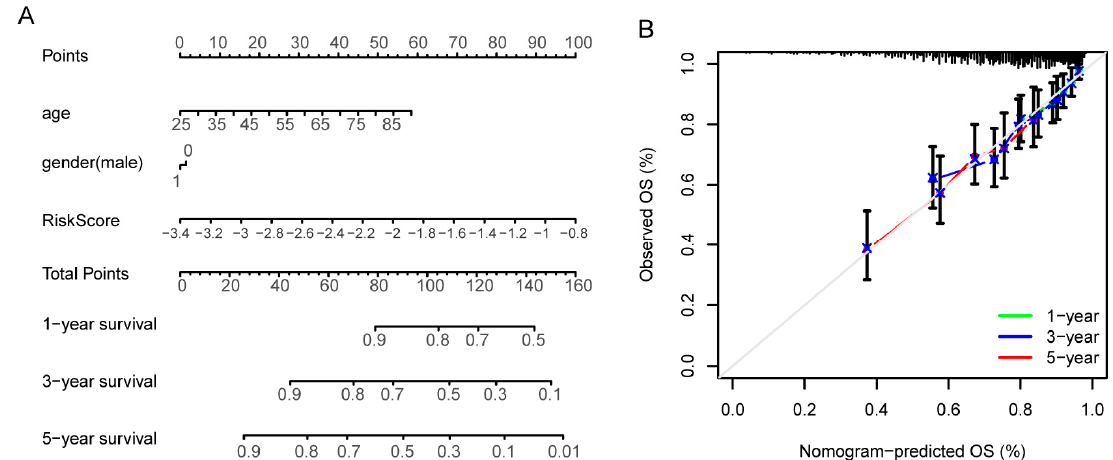
Figure 7. E ff ects of 740Y-P stimulation on autophagy-related genes in 786-O cells. *** p value < 0.001 vs. Ov-NC; ### p value < 0.001 vs. Ov-SPAG9. Ov-NC: cells transfected with control plasmids; Ov- SPAG9: cells transfected with SPAG9 plasmids; Ov-SPAG9 + 740Y-P: cells transfected with SPAG9 plasmids and stimulated by 740Y-P.